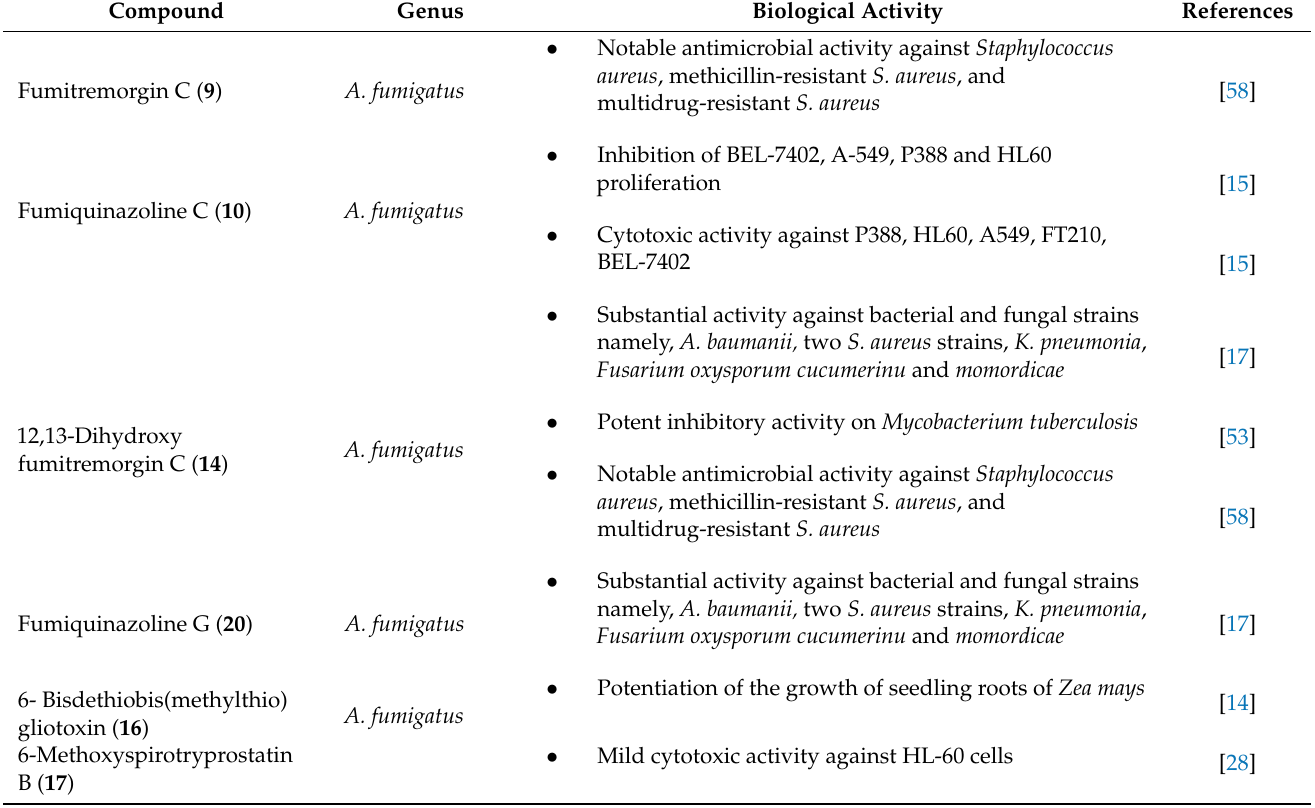
Table 2. Free binding energies ( Δ G) in Kcal/mol of alkaloids isolated from Aspergillus and showed anti-infective poten- tial using in silico studies on different microbial proteins.